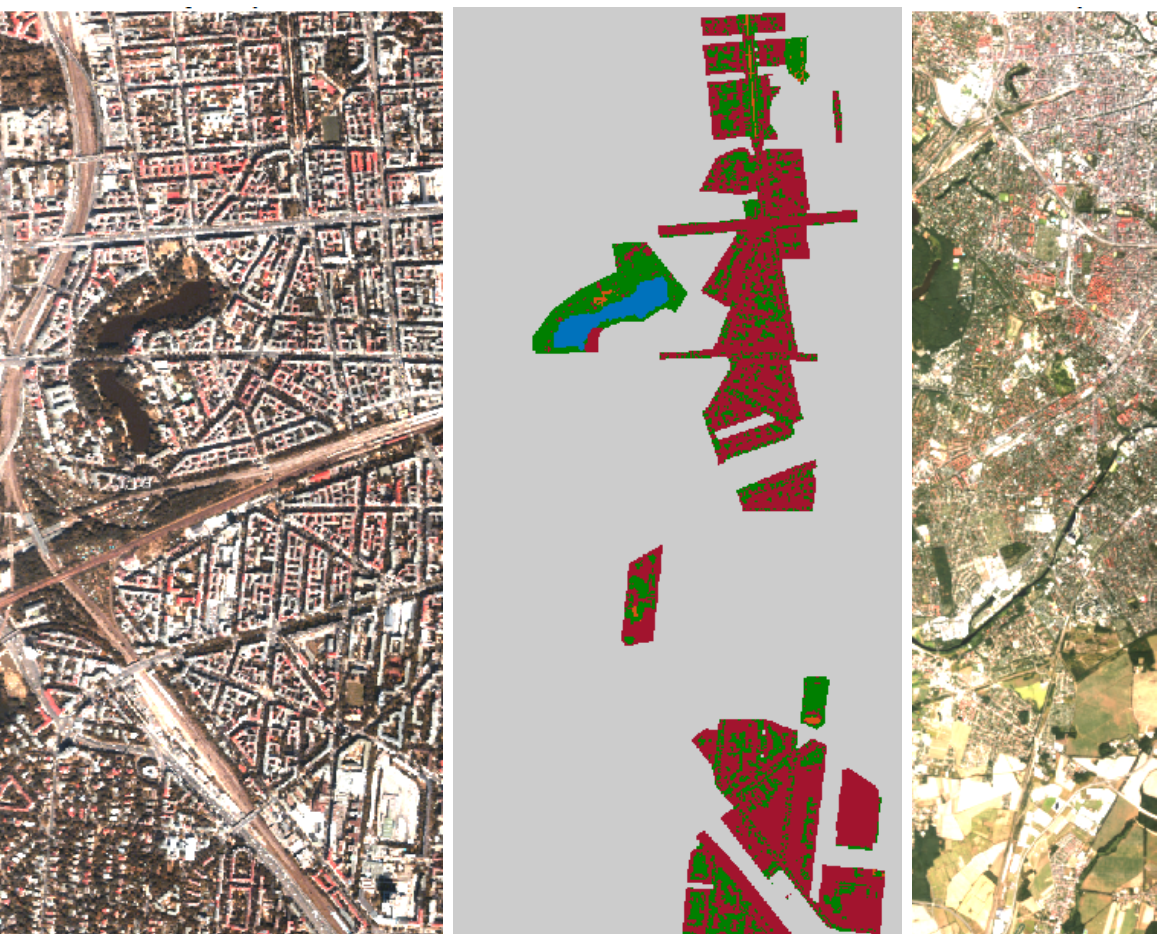
Figure 1. Berlin-Urban-Gradient